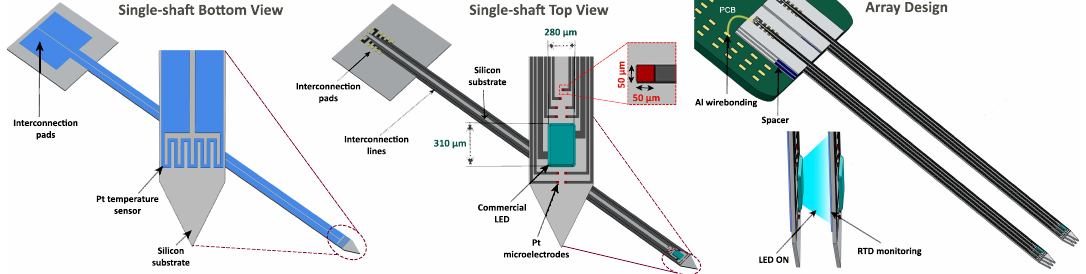
Figure 1. Design of the 3D silicon neural array concept. Pt RTD patterning on a single shaft (Bottom view), and on the opposite side 10 recording sites and a LED chip (Top view).